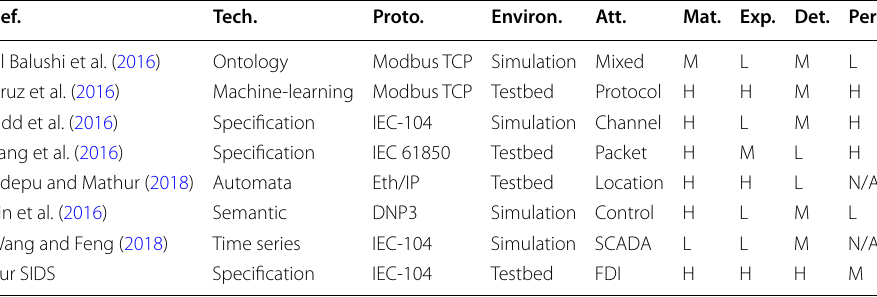
Table 4 Comparison with other intrusion detection approaches